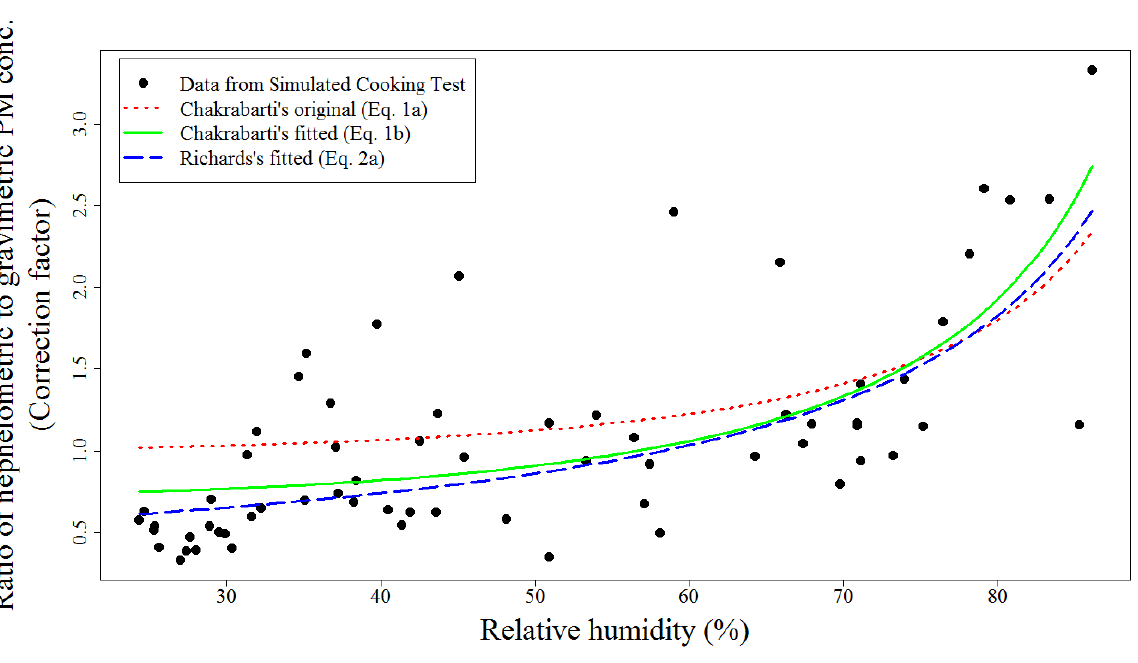
Figure 1. Humidity adjustment Equations (1 a ), (1 b ), and (2 a ) displayed with data collected during cooking for both the mock house and occupied